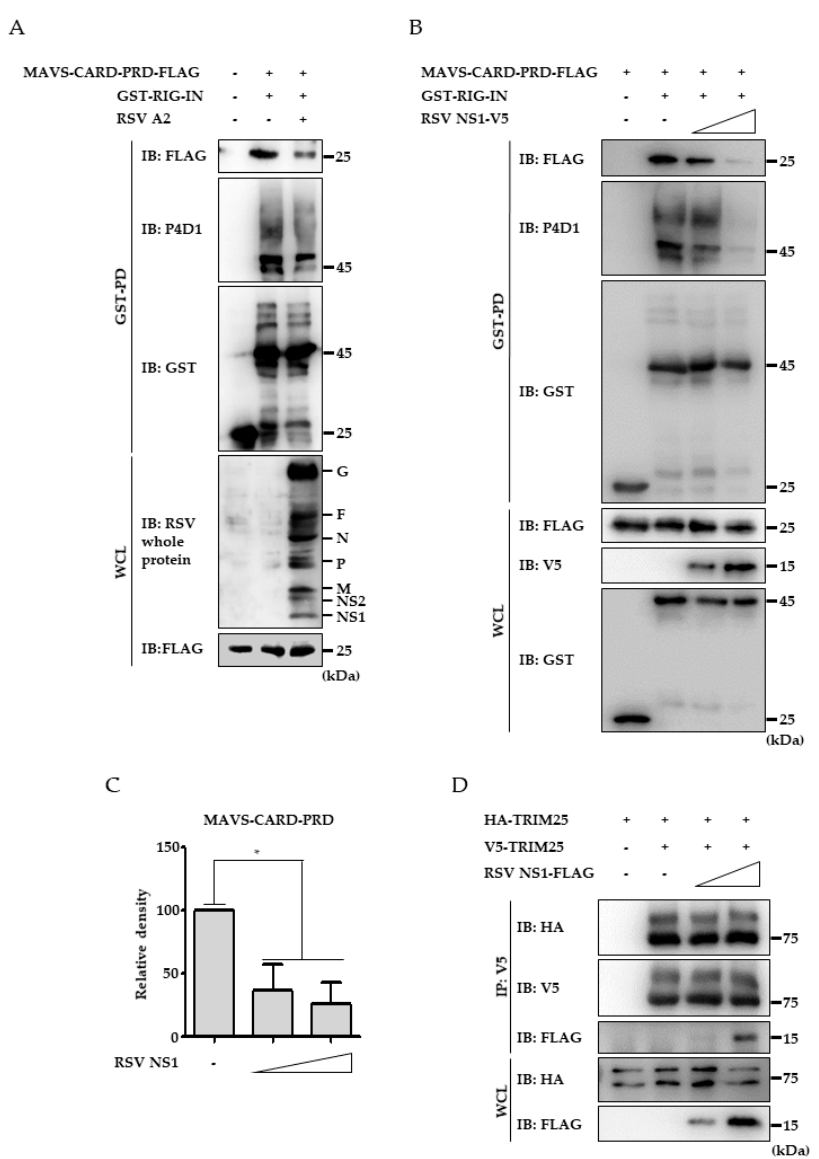
Figure 4. Inhibition of RIG-IN interaction with MAVS-CARD-PRD by RSV NS1. ( A ) GST-RIG-IN or GST vector was transfected to HEK293T cells together with MAVS-CARD-PRD-FLAG plasmid as indicated. After 24h, cells were infected with RSV (moi=4) as indicated and further incubated for 24 h. Cell lysates were subjected to GST-pulldown and immunoblotting using indicated antibodies to analyze the ubiquitination of GST-RIG-IN. ( B ) MAVS-CARD-PRD-FLAG, RSV NS1-V5 and GST-RIG-IN or GST vector plasmids were transfected into HEK293T cells as indicated. The lysates (WCL) were analyzed by co-IP and immunoblotting. Ubiquitinated forms were detected using anti-ubiquitin antibody (P4D1). ( C ) Densitometric analysis of the precipitated MAVS-CARD-PRD-FLAG. The levels of co-precipitated MAVS-CARD-PRD-FLAG were analyzed by densitometry using Vision-Capt software and normalized to the levels of pulled-down GST-RIG-IN. ( D ) HA- and V5-tagged TRIM25 (10 µ g/ Φ 10 cm dish) with or without FLAG-tagged NS1 (0, 4 or 8 μ g/ Φ 10 cm dish) were transfected into HEK293T cells as indicated. Interaction between HA-TRIM25 and V5-TRIM25 was analyzed by co-IP and immunoblotting using indicated antibodies. All experiments were conducted at least three times with similar